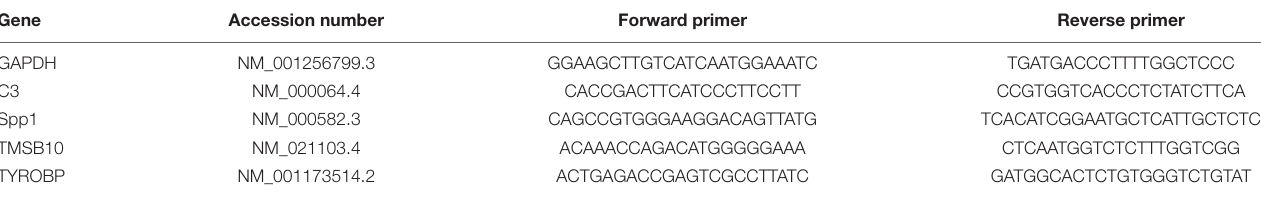
TABLE 3 | The primer sequences used in the